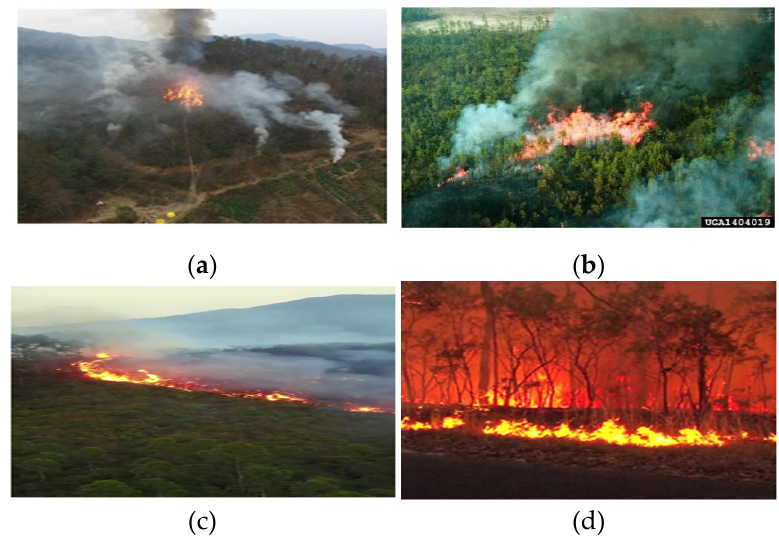
Figure 1. Sample images in the training set: ( a – d ) forest fire targets at different scales.